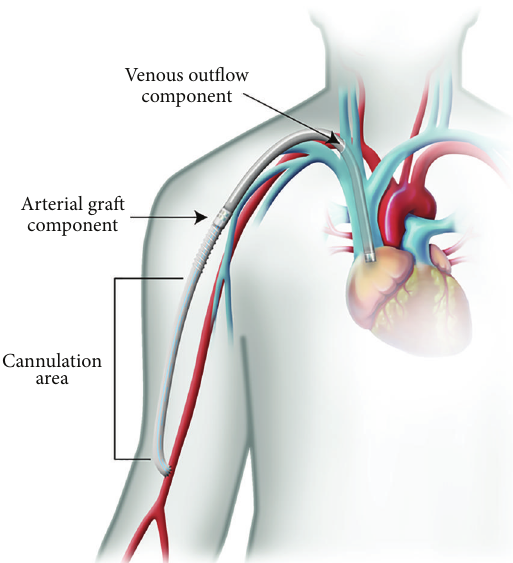
Figure 2: Used with the permission of CryoLife,